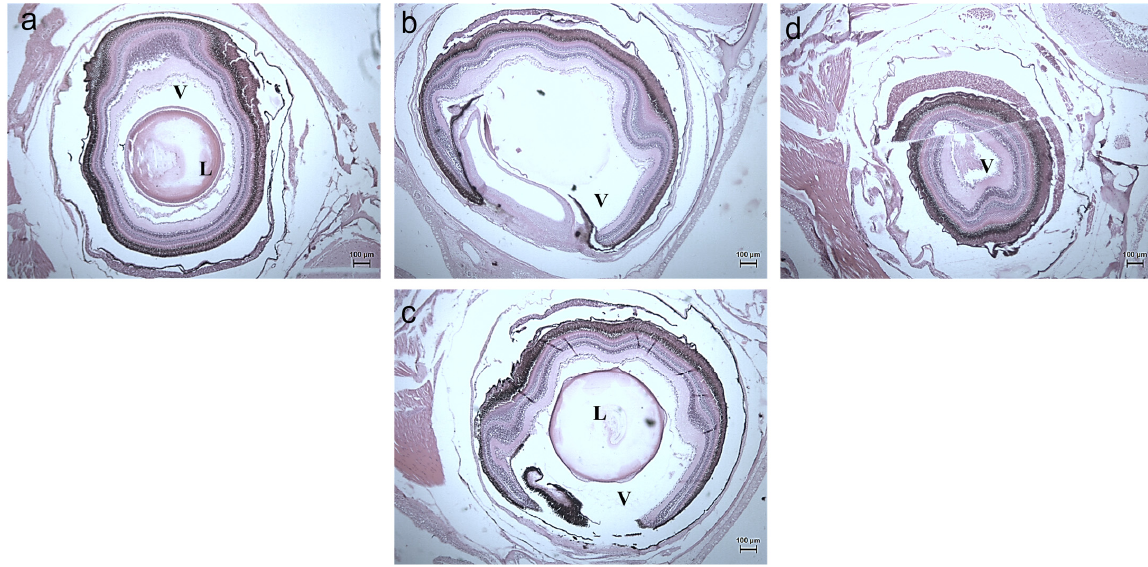
Figure 14. Histology images of eyes of Zebrafish— Danio rerio (10X Magnification) ( a ) 10th day Control, ( b ) 20th day Control, ( c ) exposed to 10 µg at 20th day, ( d ) 30th day Control. L–Lens, V–Vitreous.